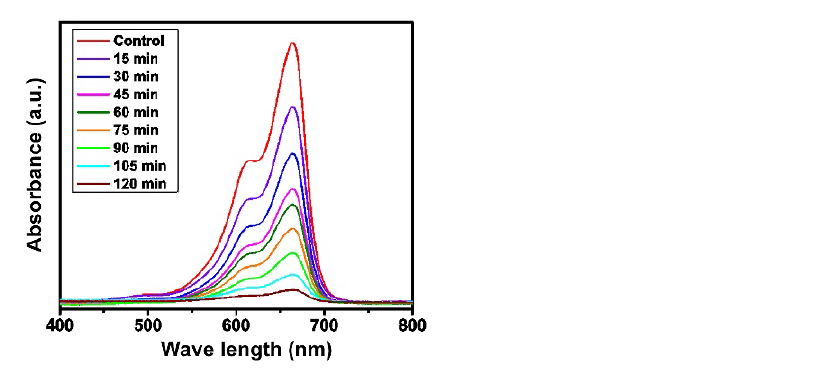
Figure 4. UV–visible analysis for the photodegradation of MB by compound 1 .